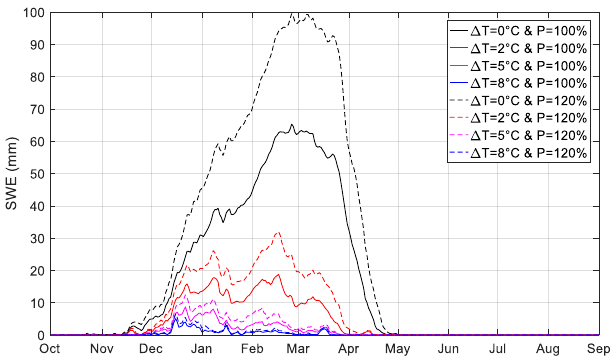
Figure 8. Sensitivity of snow accumulation to selected climate change scenarios.